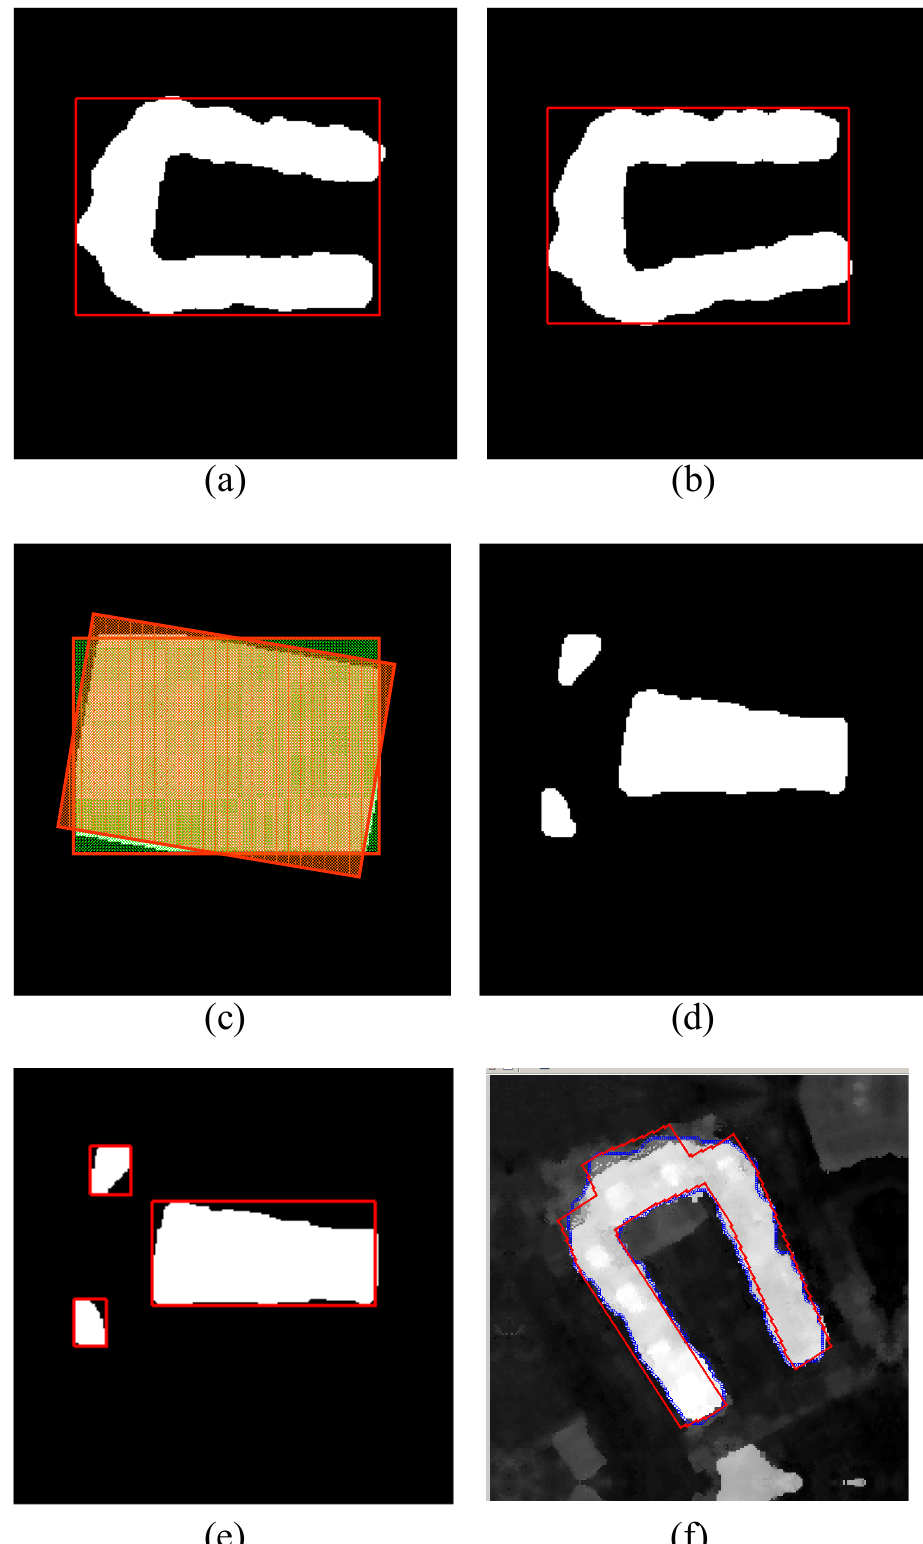
Figure 12. CMBR-based polygon approximation. ( a ) MBR model 1 (red); ( b ) Remaining regions in first orientation; ( c ) Intersection of two MBRs; ( d ) Remaining regions in first orientation; ( e ) Fitting MBR to remaining regions; ( f ) Approximation based on two